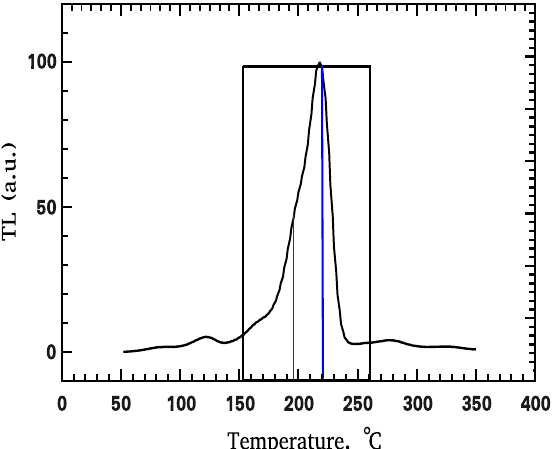
Figure 1. Traditional methods to extract the TL intensity from experimental glow curves either by selecting the peak height at some point of the glow curves (perpendicular lines) or by integrating the signal between two temperatures (region within the